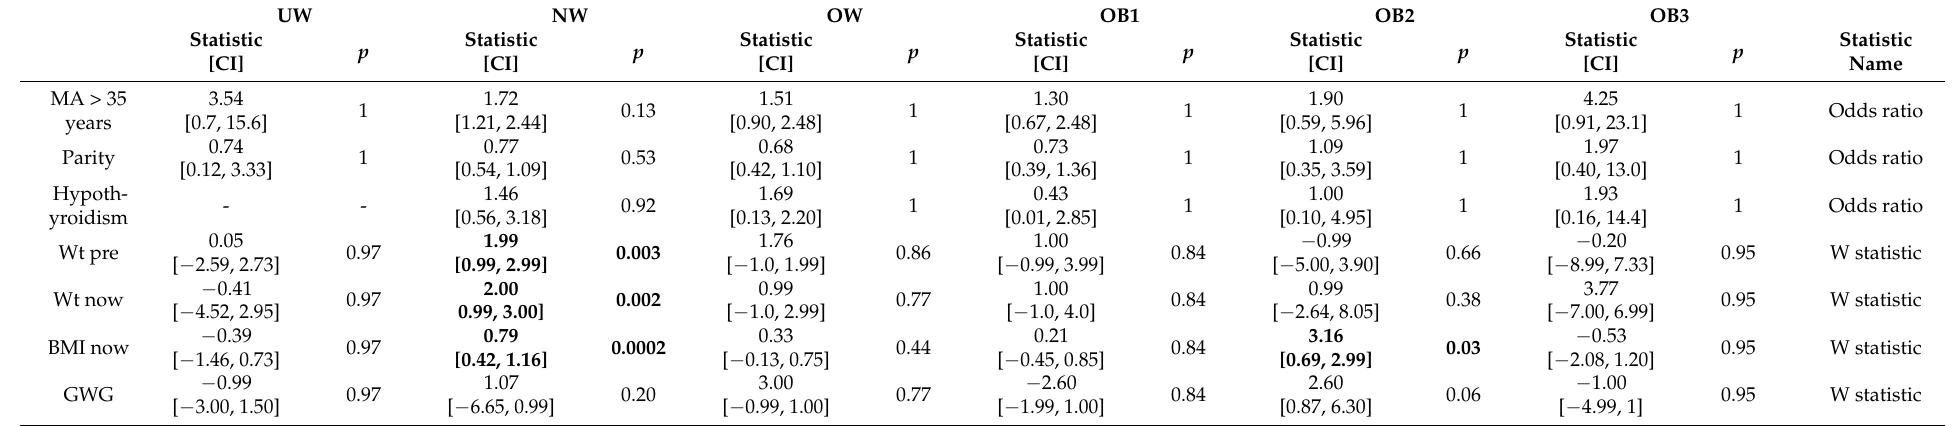
Table 4. Subgroup crude analysis for underweight, normal weight, and overweight individuals based on BMI classification for outcome